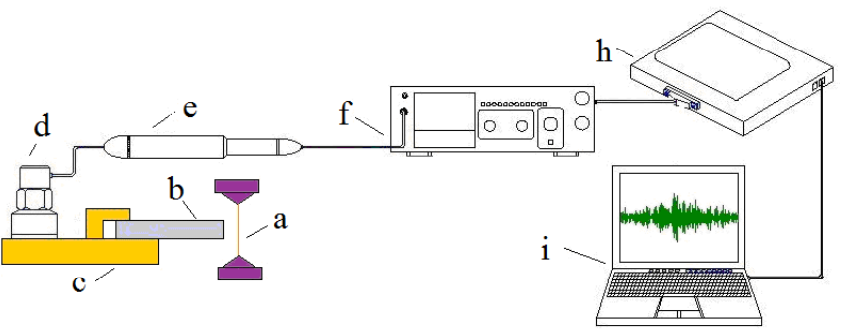
Figure 1. Composition of equipment for monitoring AE signals in WEDM of hard alloys: a—wire-tool; b—workpiece; c—working table; d—accelerometers; e—preamplifiers; f—amplifiers model VShV003 (Izmeritel Ltd., St. Petersburg, Russia); h—external ADC module model E440 (L-CARD Ltd., Moscow, Russia); i—signal-recording device.